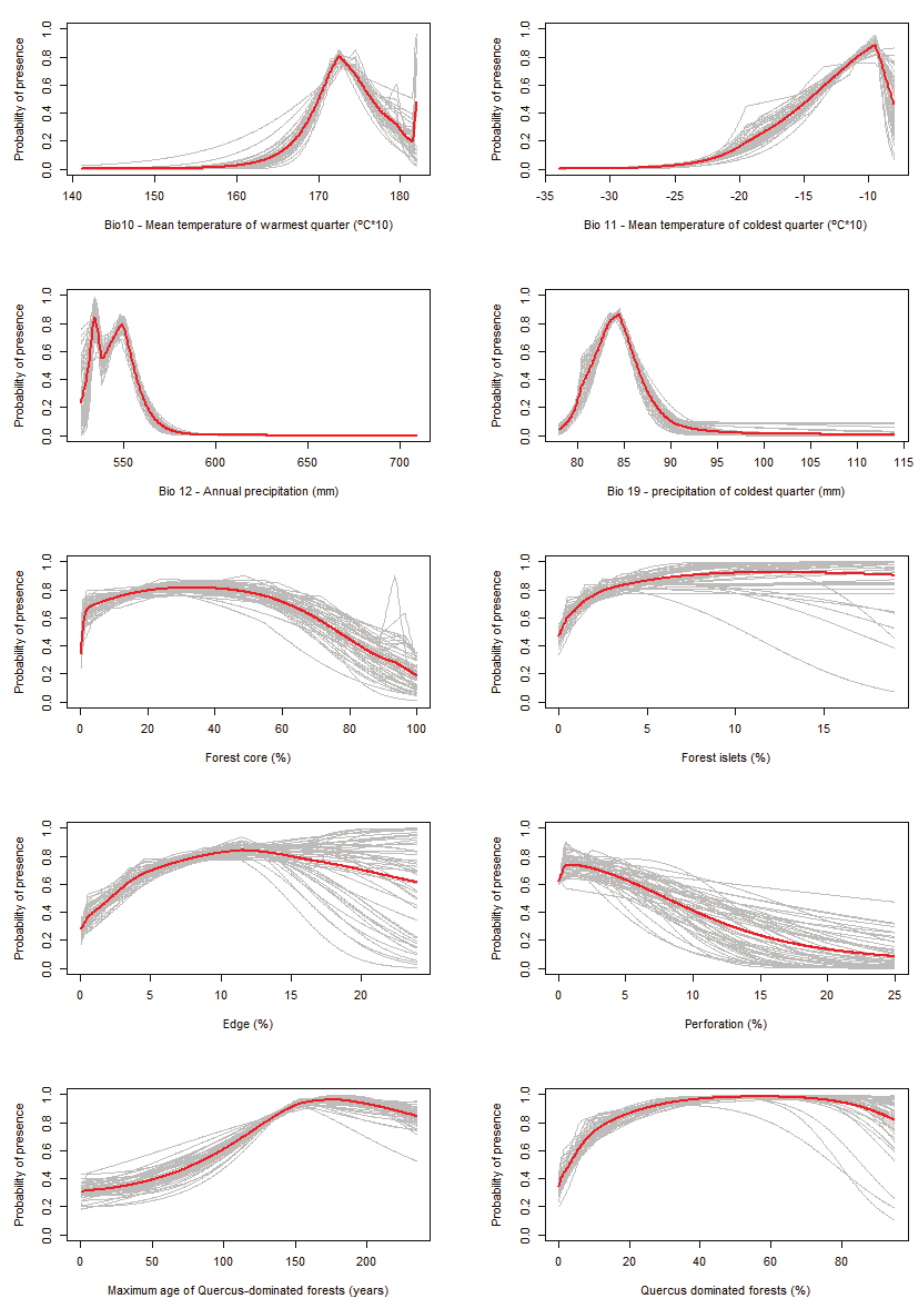
Figure 6. Response of Cerambyx cerdo L., 1758 (cloglog distribution of occurrence probability) to envi- ronmental variables used in ecological niche modelling with MaxEnt. Response curves for all 50 bootstrap models are shown with the mean curve in